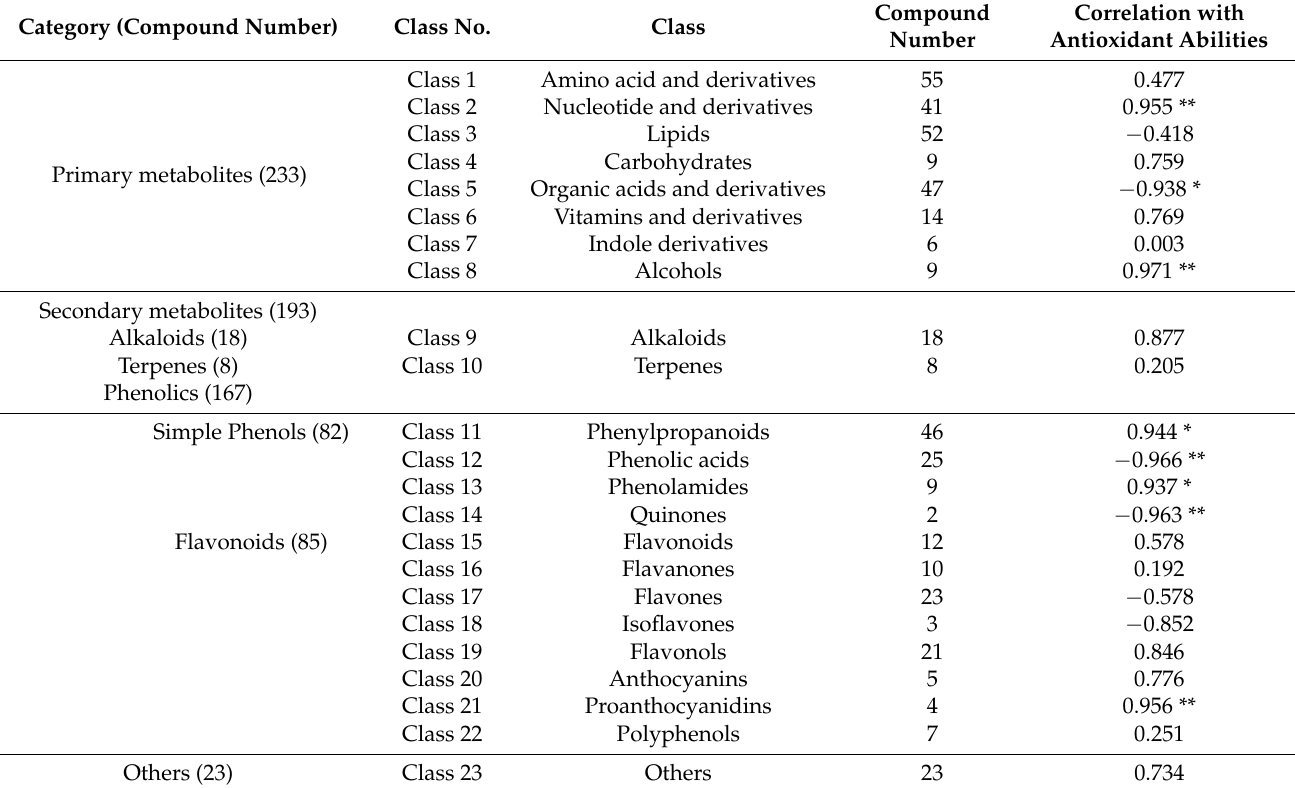
Table 1. The 449 metabolites identified in sweetpotato leaves of “Chuanshan Zi”. Class